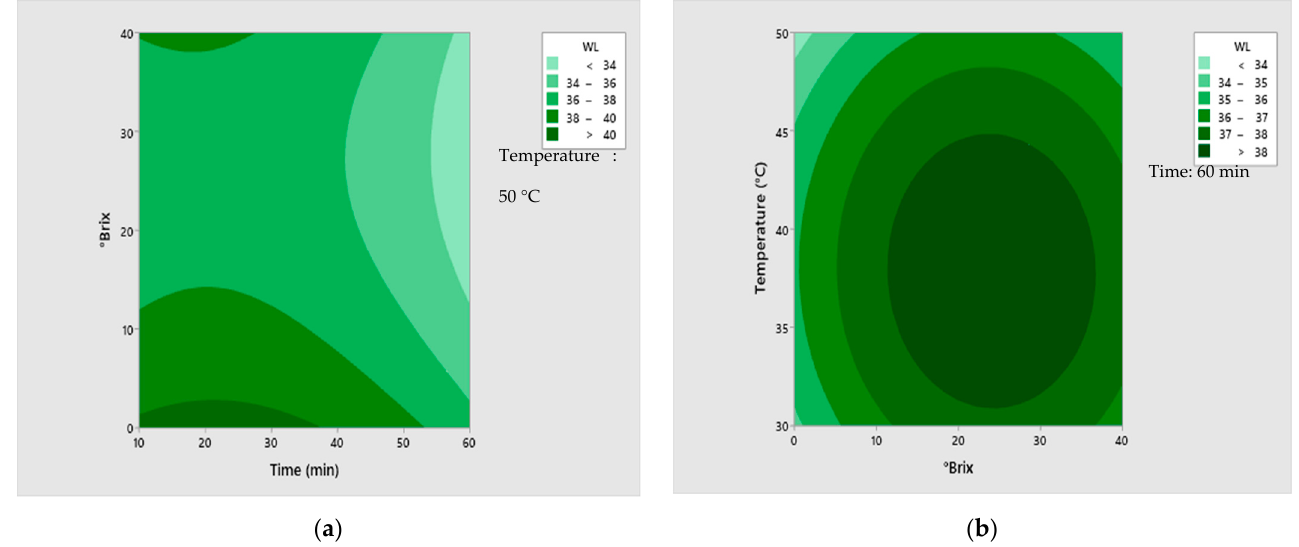
Figure 1. Influence of time–°Brix and temperature–°Brix on water loss ( a ) using, respectively, erythritol ( a ) and sorbitol ( b ) osmotic agents.